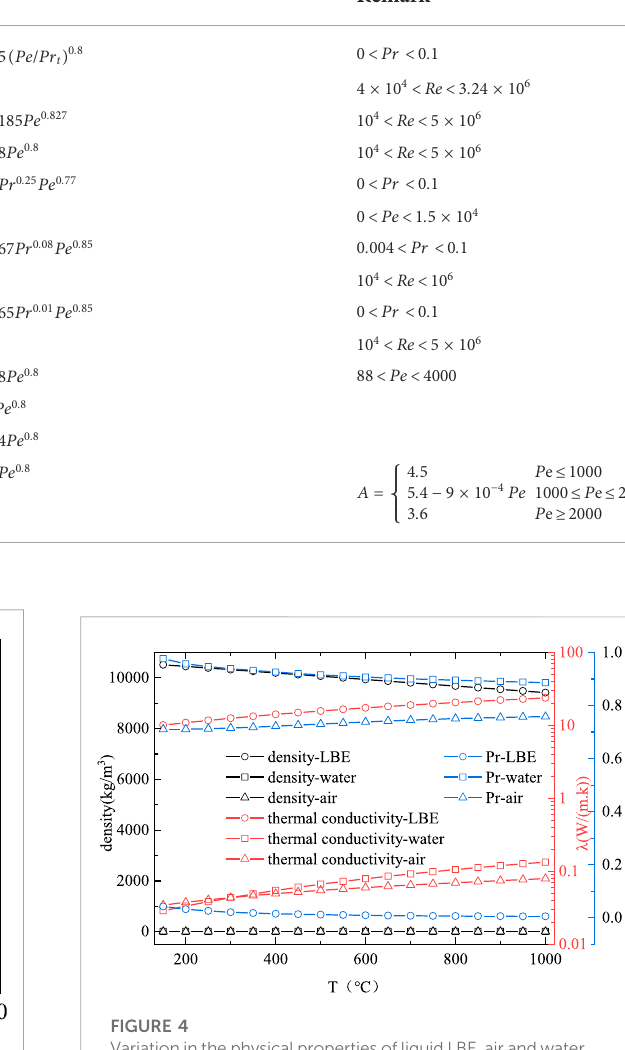
FIGURE 4 Variation inthephysical propertiesofliquidLBE,airandwater with different